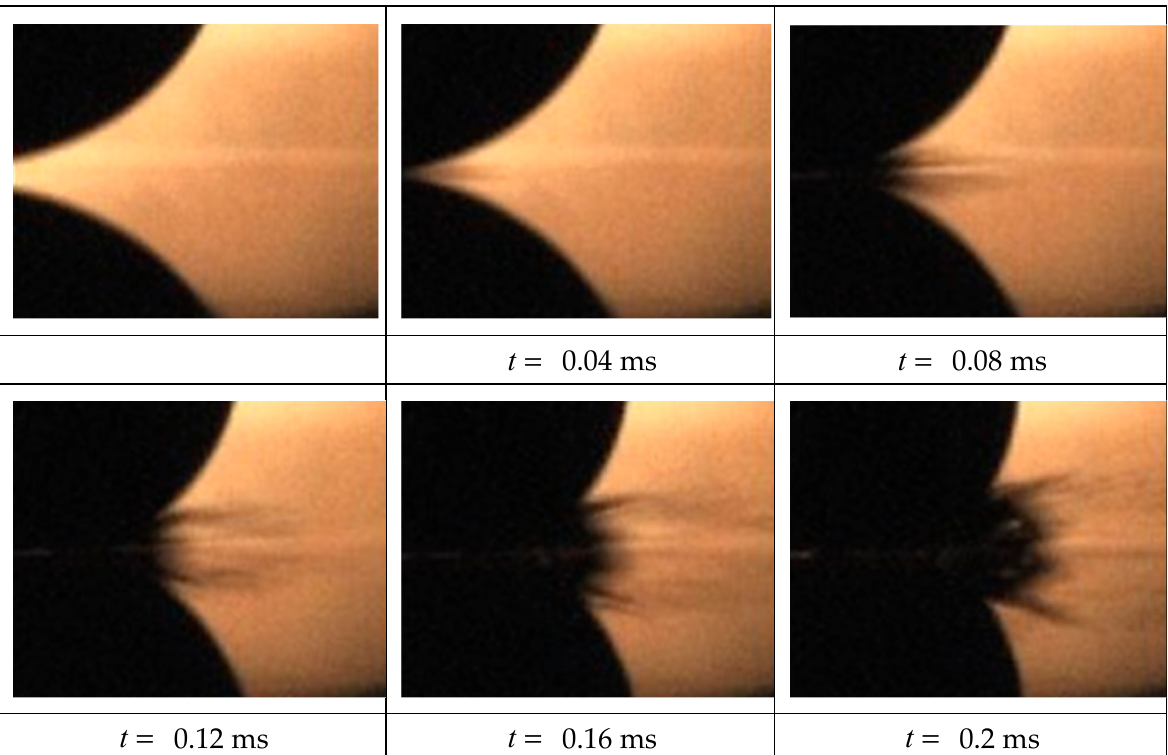
Figure 18. Ejecta veil and fast jets at the beginning of the droplet merging with the target fluid at rest in the impact mode ( D = 4.3 mm, U = 3.1 m/s, ink solution diluted in range 1:200, frame rate 25,000 fps, sight line directed at α = 2 ◦ to the